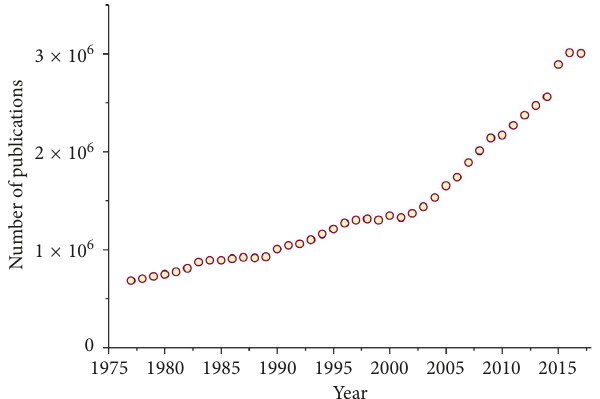
Figure 1: The increasing number of publications per year over the last 40years (1978–2017, Source: Web of